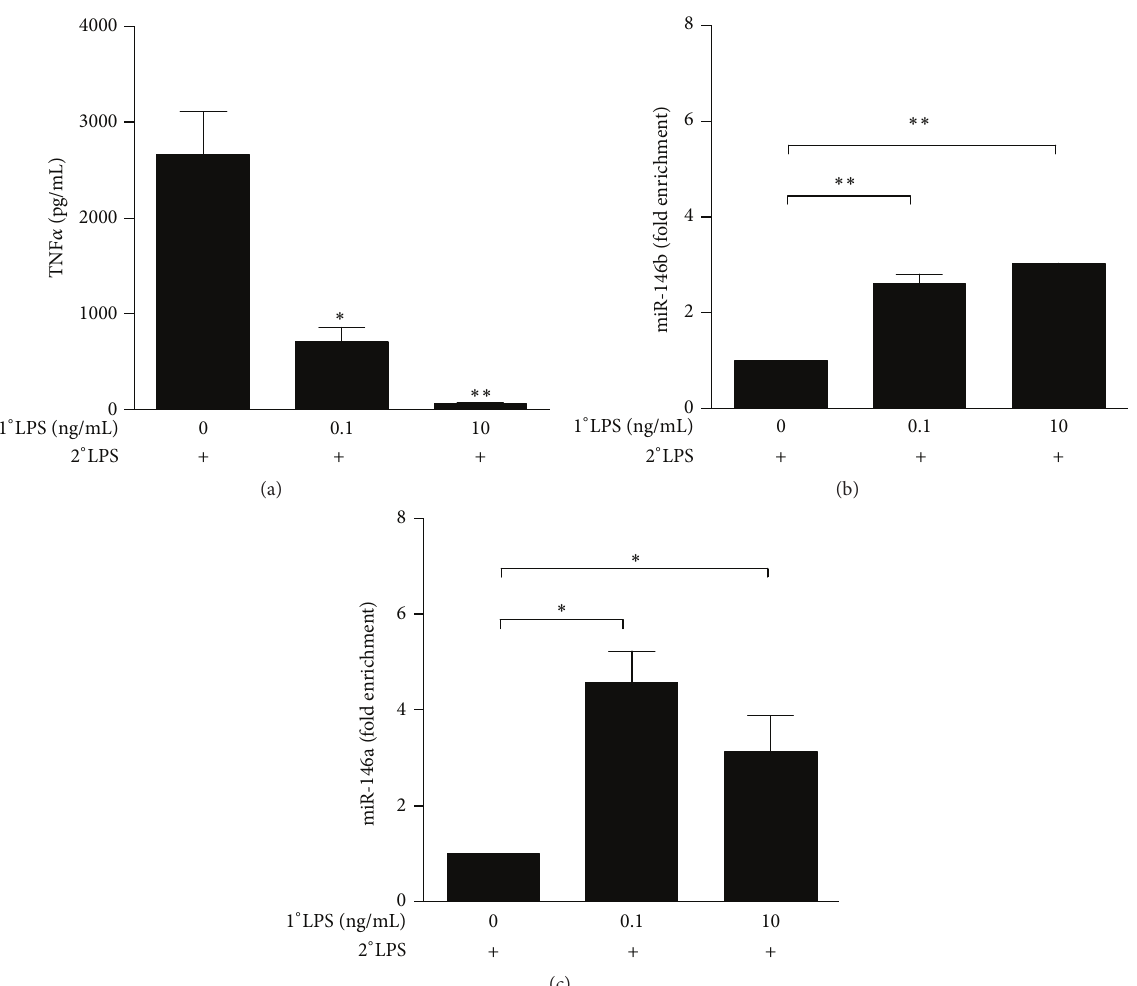
Figure 2: miR-146b and miR-146a are induced in endotoxin tolerized monocytes . Monocytes were first primed with 0, 0.1, or 10 ng/mL LPS (1 ∘ LPS) for 18h and then challenged for 24 h with 10ng/mL LPS (2 ∘ LPS). After 24 h stimulation, TNF 𝛼 levels (a) were measured by ELISA in cell-free supernatants, and levels of (b) miR-146b and (c) miR-146a were assayed by qPCR in triplicate samples, normalized relative to U6, and expressed as fold enrichment as compared to unstimulated samples. Results are expressed as mean ± SEM of three independent experiments.